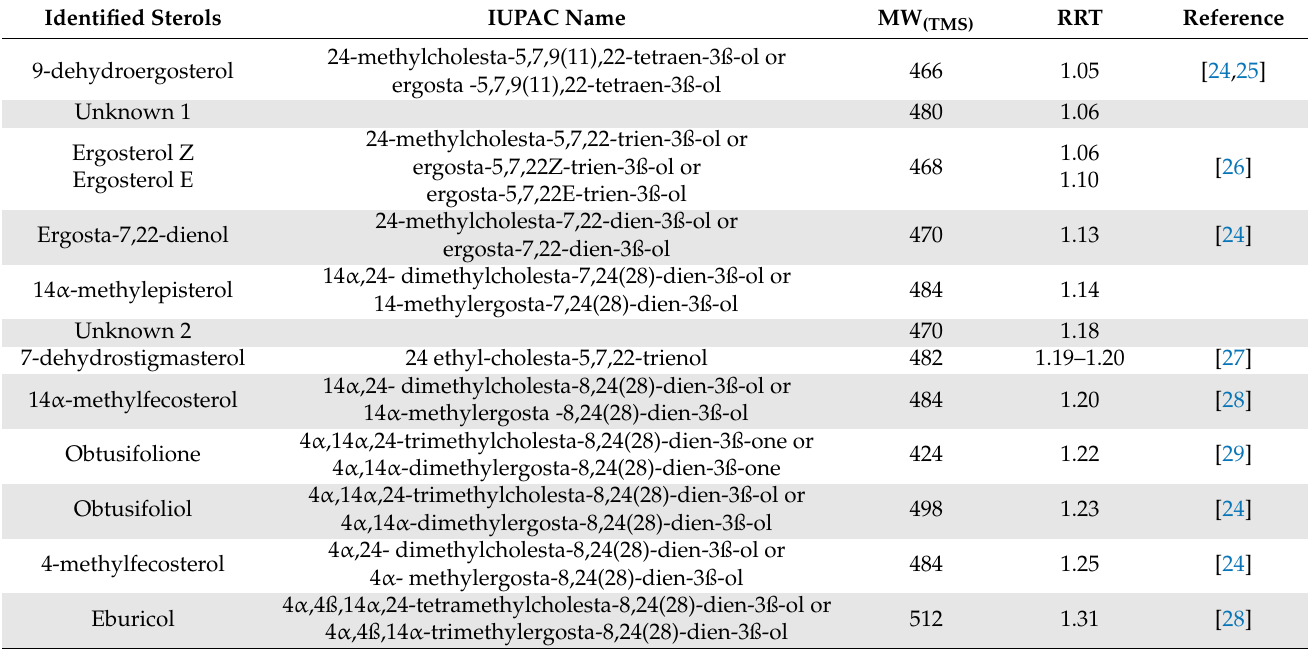
Table 2. List of the 13 sterols present with an amount higher than 1% of the total amount of sterols and identified during this